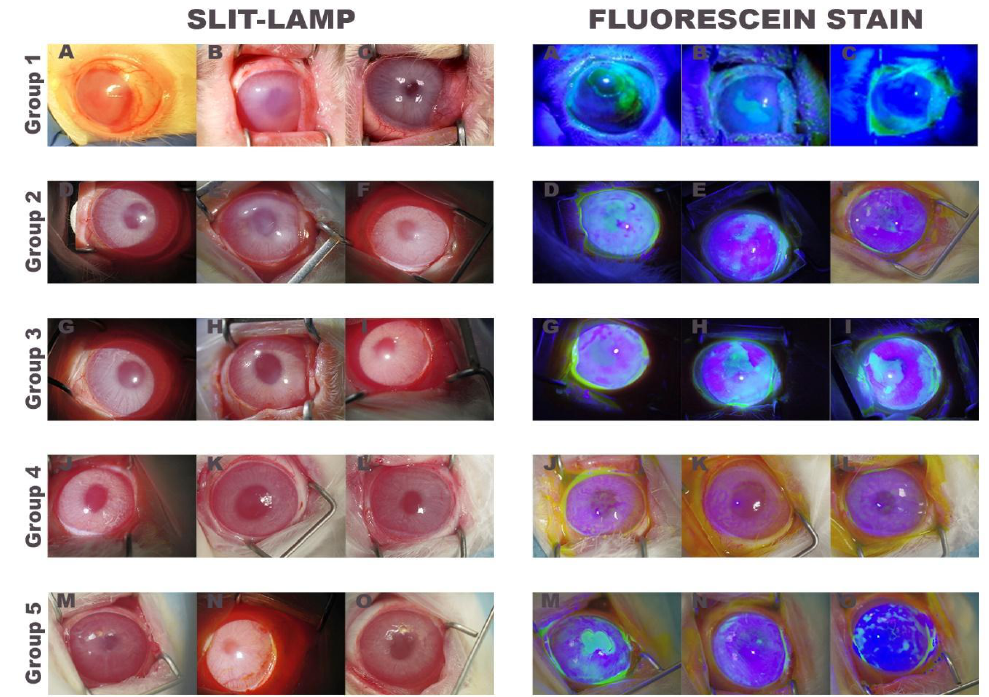
Figure 2. Appearance of rabbit eyes seven days after alkali-burn lesion. Slit-lamp photographs (left) and fluorescein stain photographs (right) of the three treated rabbits of each group. Group 1: only medical treatment (control group), Group 2: fibrin-PRGF membrane cultured with autologous rabbit LEPCs, Group 3: fibrin-PRGF membrane cultured with heterologous rabbit LEPCs, Group 4: fibrin-PRGF membrane SLET and Group 5: fibrin-PRGF membrane without rabbit cultured LEPCs. PRGF: Plasma Rich in Growth Factors; LEPCs: Limbal Epithelial Progenitor Cells; SLET: Simple Limbal Epithelial Transplantation.